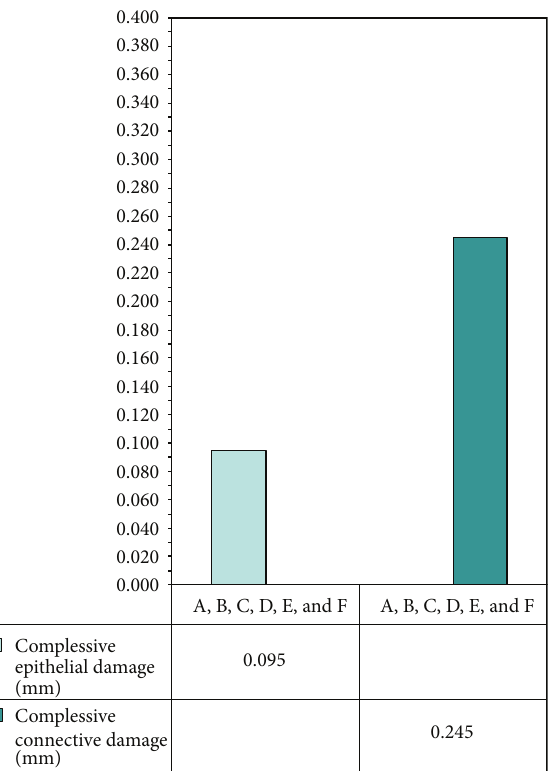
Figure 8: Bar chart referring to the average thermal damage to epithelial and connective tissue on all specimens.